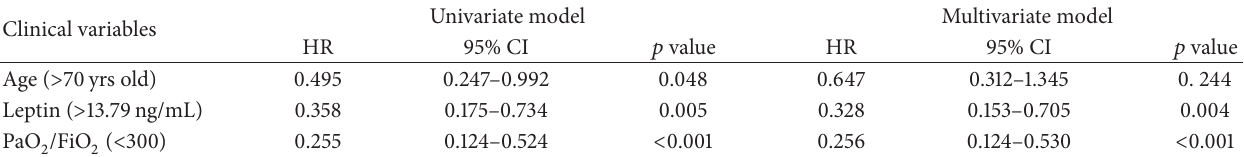
Table 3: Cox proportional hazards models for time-to-death among 62 patients with